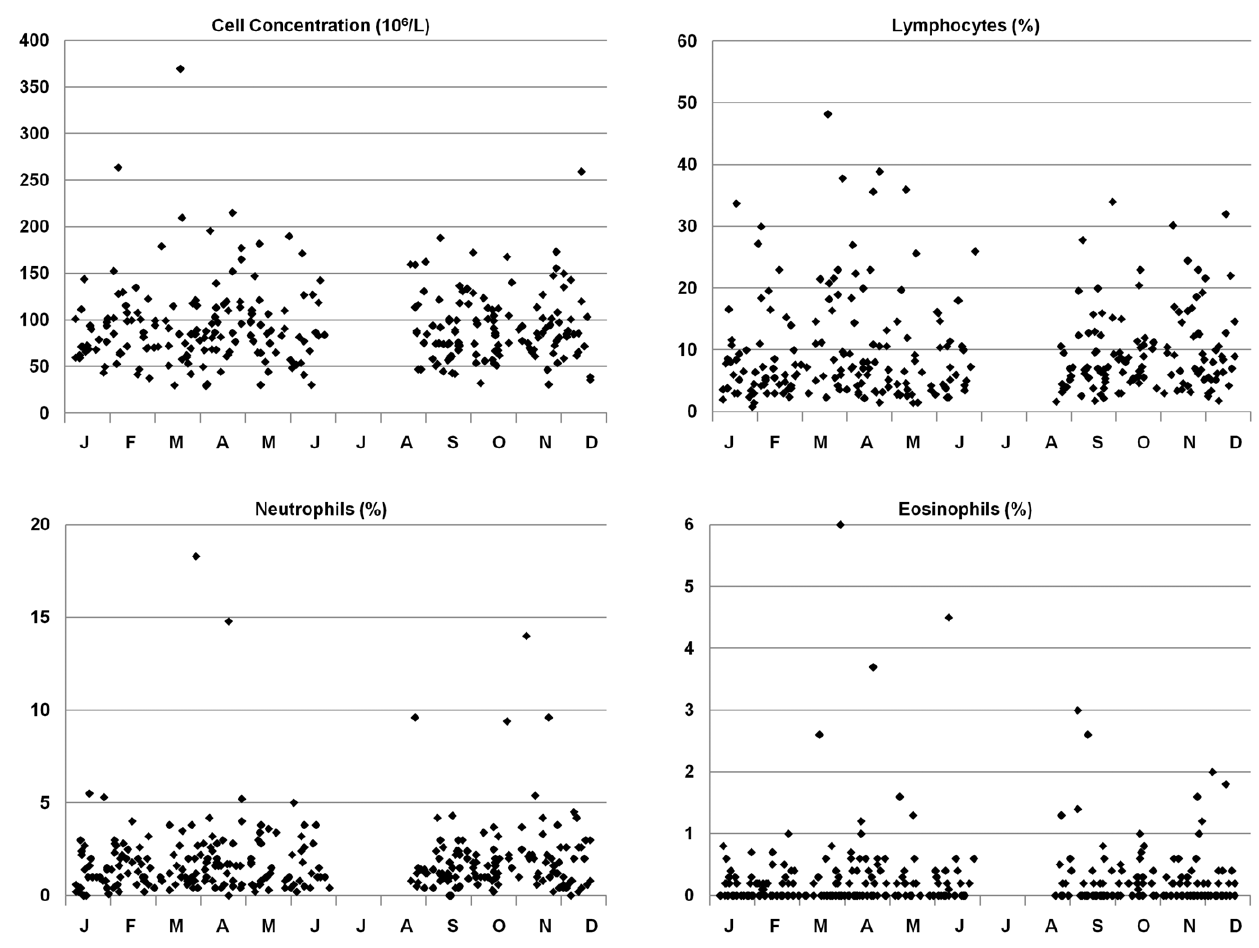
Figure 4. Bronchoalveolar lavage fluid findings (y-axis) during the calendar month (x-axis) in healthy never-smoking subjects.